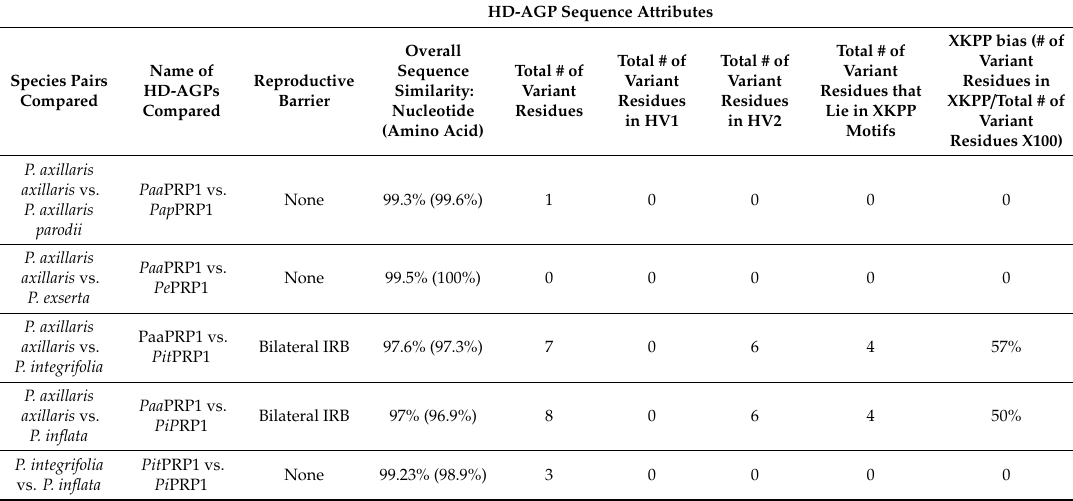
Figure 5. Multiple alignments of HD-AGP protein sequences from P. axillaris axillaris ( Paa PRP1), P. axillaris parodii ( Pap PRP1), P. exserta ( Pe PRP1), P. integrifolia ( Pit PRP1), and P. inflata ( Pi PRP1). The numbers at the end of the row indicate amino acid positions. The signal peptide sequence is shown with a dotted line above it; the two hypervariable domains, HVI and HV2, are boxed in green and red, respectively; a black line lies over the histidine-rich domain; the highly conserved PAC / Ole-1 domain is highlighted in blue. The residues highlighted in yellow are conserved in all solanaceous HD-AGPs described so far, and they flank the HV2 domain in all HD-AGPs. Table 2. Comparison of sequence variation in HD-AGPs from hybridizing and non-hybridizing Petunia species. Bilateral IRB refers to the failure to set seed in either direction. The underlying mechanisms, in this case, are SI-related IRB when the SI species is the female partner, and incongruity when the SC species is the female partner. Cross-hybridizing Petunia species pairs display little to no sequence variation at the protein level. When non-hybridizing species-pairs are compared, sequence variation is seen mainly in the HV2 domain and is strongly biased toward variation in the number of the XKPP tetrapeptides in this